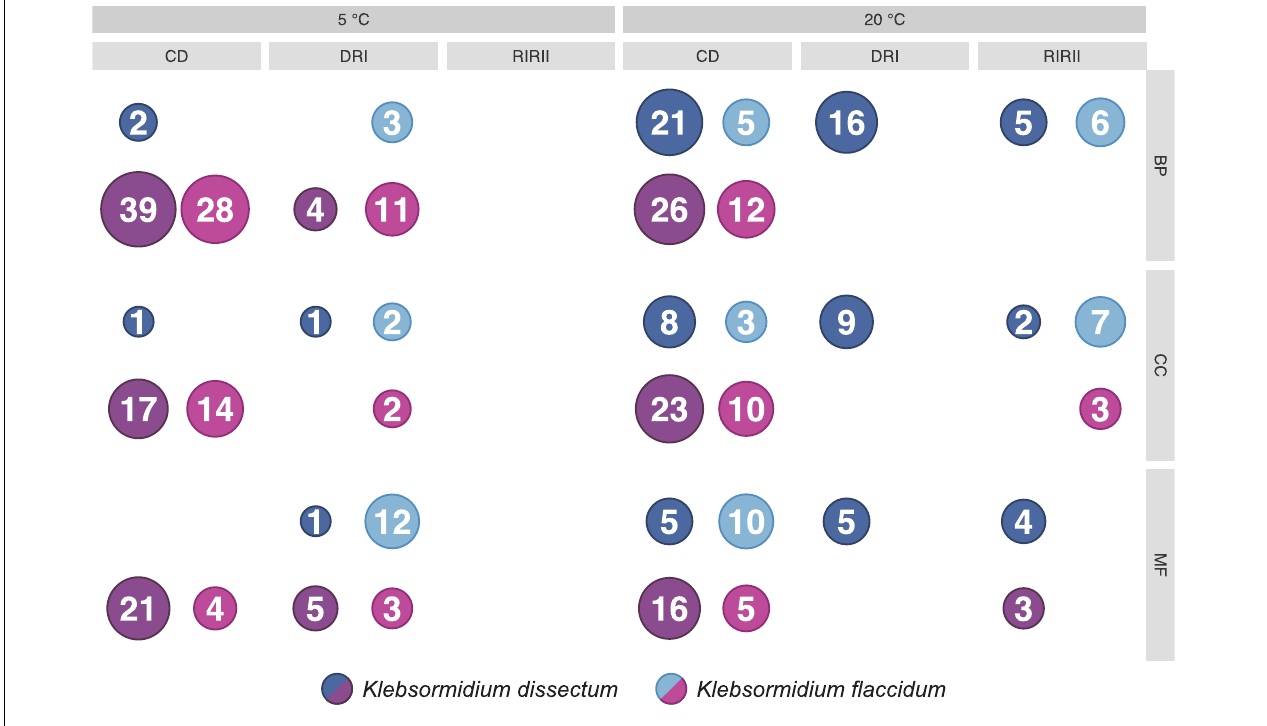
FIGURE 7 | Summary of the GO enrichment analysis. The number of enriched categories, classified according to the three root categories, in the up- and down-regulated part of the transcriptomes are indicated. The detailed GO enrichment analysis is presented in Supplementary Table S2